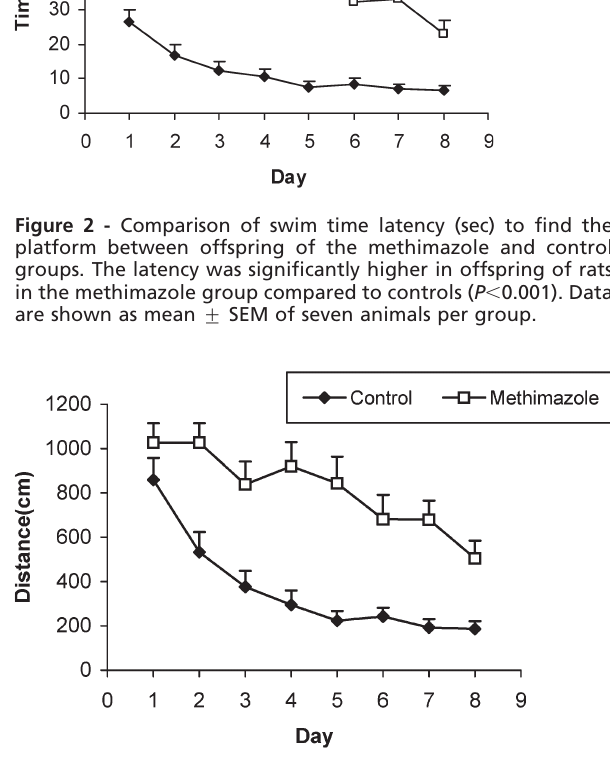
Figure 3 - Comparison of the length of the swimming path (cm) between methimazole-treated animals and controls using a repeated measure ANOVA. The length of the swimming path in the offspring of the methimazole group was significantly higher than that of controls ( P , 0.001). Data are shown as mean ¡ SEM of seven animals per group.